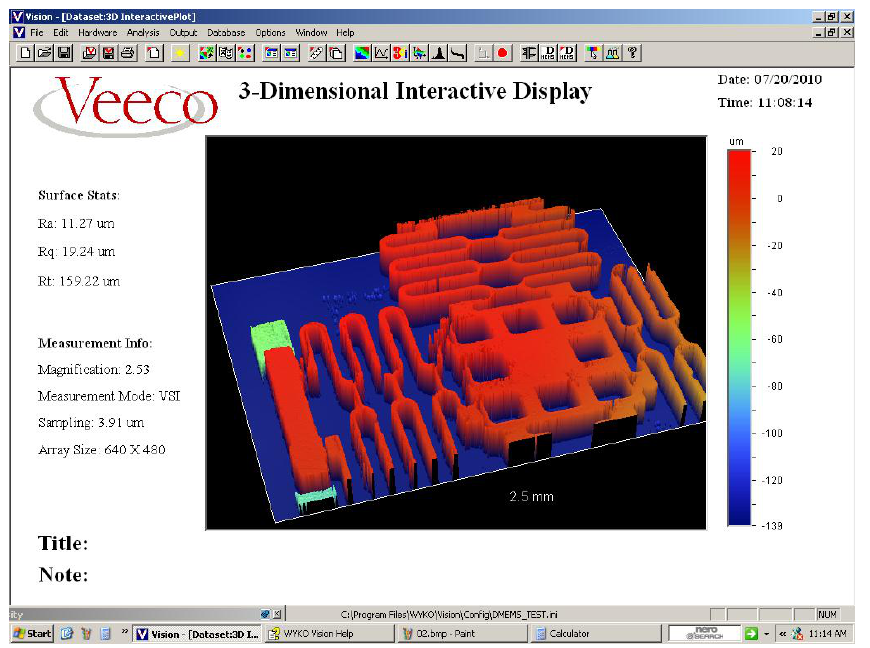
Figure 12. The optical profile of the electromagnetic bistable microswitch.